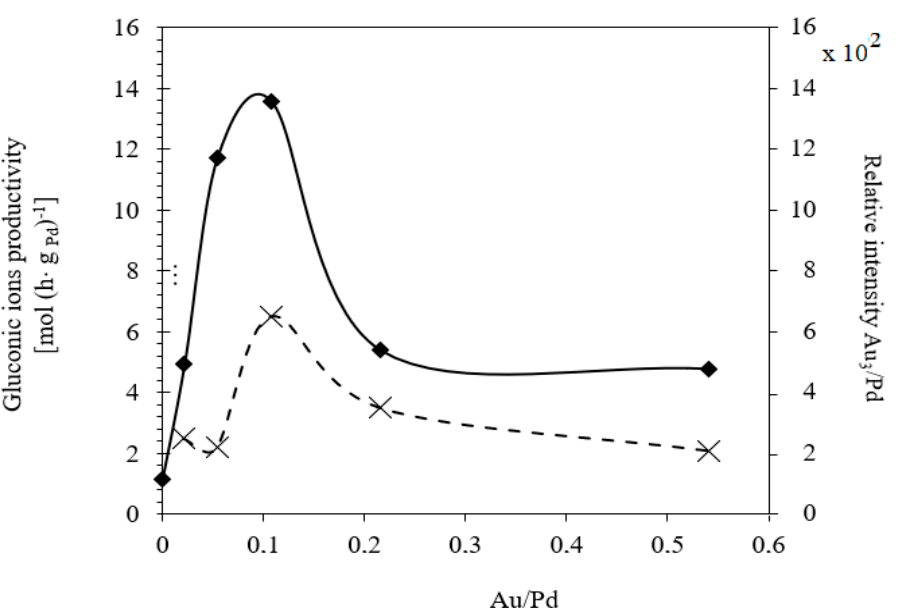
Figure 4. Gluconic ions productivity and relative intensity of Au 3 /Pd ions as a function of the atomic ratio of Au/Pd in bimetallic Pd-Au/SiO 2 catalysts. Productivity was estimated after 2 h runs over bimetallic catalysts with various compositions of the active phase. Reaction conditions: T = 60 ◦ C,